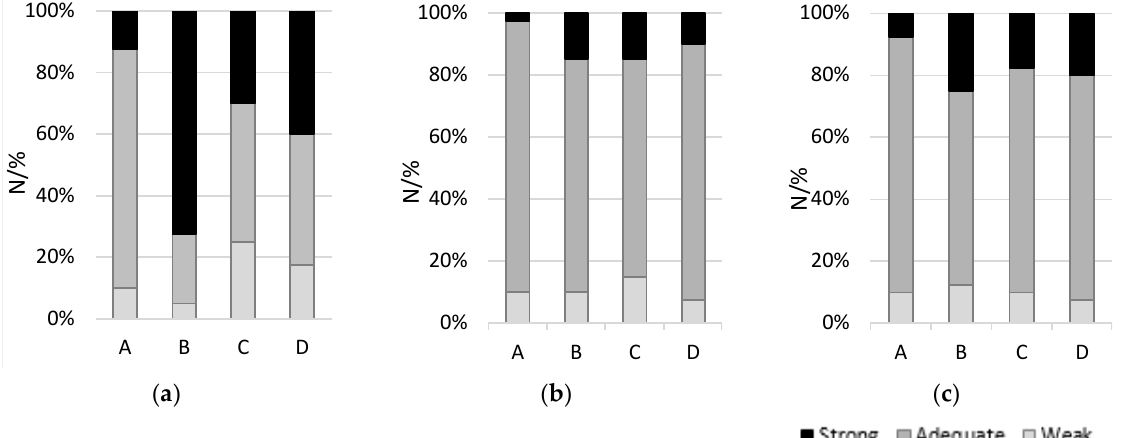
Figure 1. Intensity scores of sensory attributes: ( a ) Aroma; ( b ) Saltiness; ( c ) Acidity. Formulations: A (thyme); B (thyme + garlic + sage); C (thyme + sage); D (thyme + garlic). Base formulation composed of whey cheese, 85% ( w / w ); SCWP, 5% ( w / w ) and probiotic culture, 10% ( v / w ). Essential oils were added at 0.025% ( w / w ) concentration.